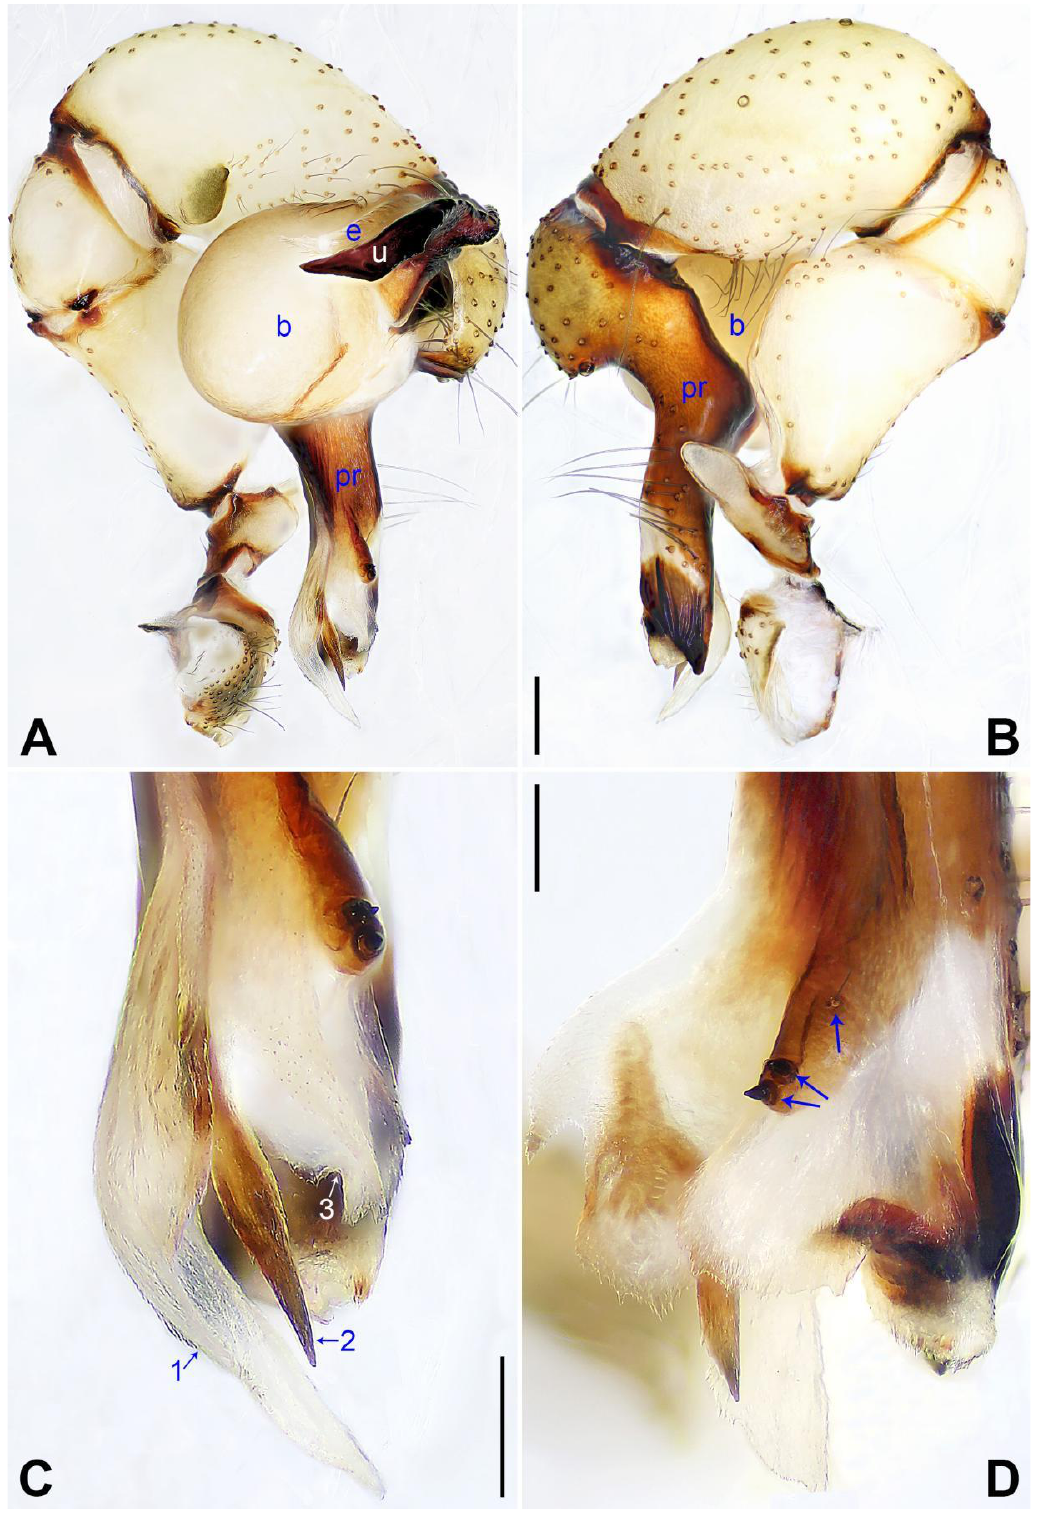
Figure 3. Pholcus jiaocheng sp. nov., holotype male: ( A ) pedipalp, prolateral view; ( B ) pedipalp, retrolateral view; ( C ) distal part of procursus, prolateral view (arrow 1 points at prolateral membranous process, arrow 2 points at pointed distal apophysis, arrow 3 points at dorsal membranous lamella); ( D ) distal part of procursus, dorsal view (arrows point at dorsal spines). b = bulb, e = embolus, pr = procursus, u = uncus. Scale bars: ( A , B ) = 0.20 mm; ( C , D ) = 0.10 mm.